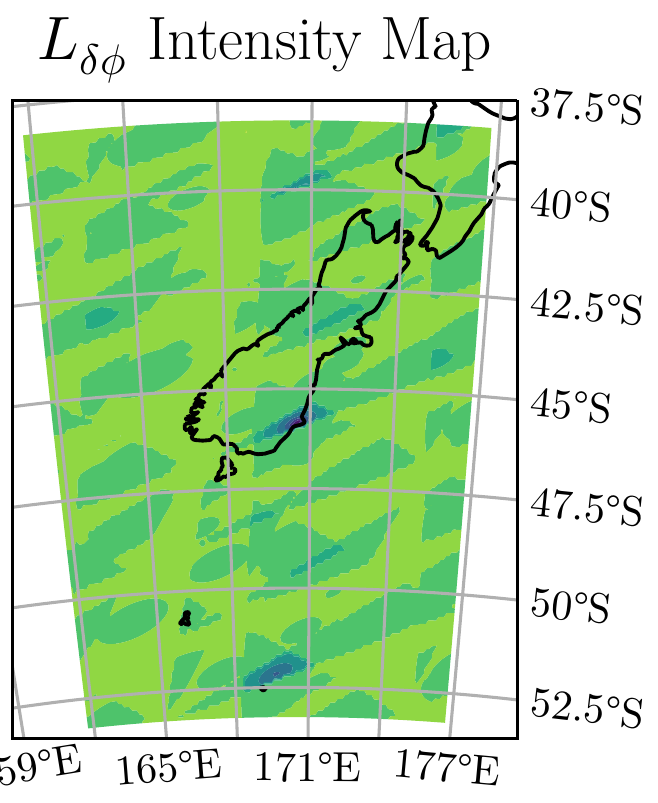
Figure 5. Least squares intensity map of L δφ , centered around the receiver location. Many local minima can be seen separated by approximately 300